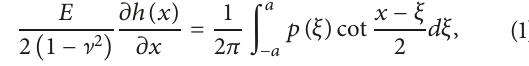
for initial contact the interplay between harmonics